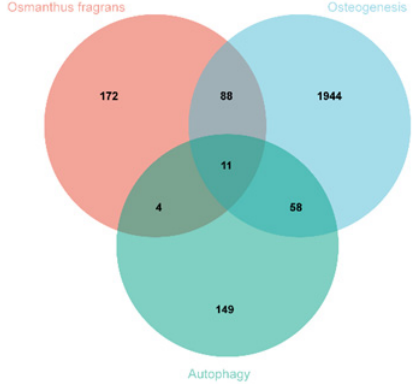
Figure 2. Identification of overlapping osmanthus fragrans, osteogenesis-, and autophagy-related genes.